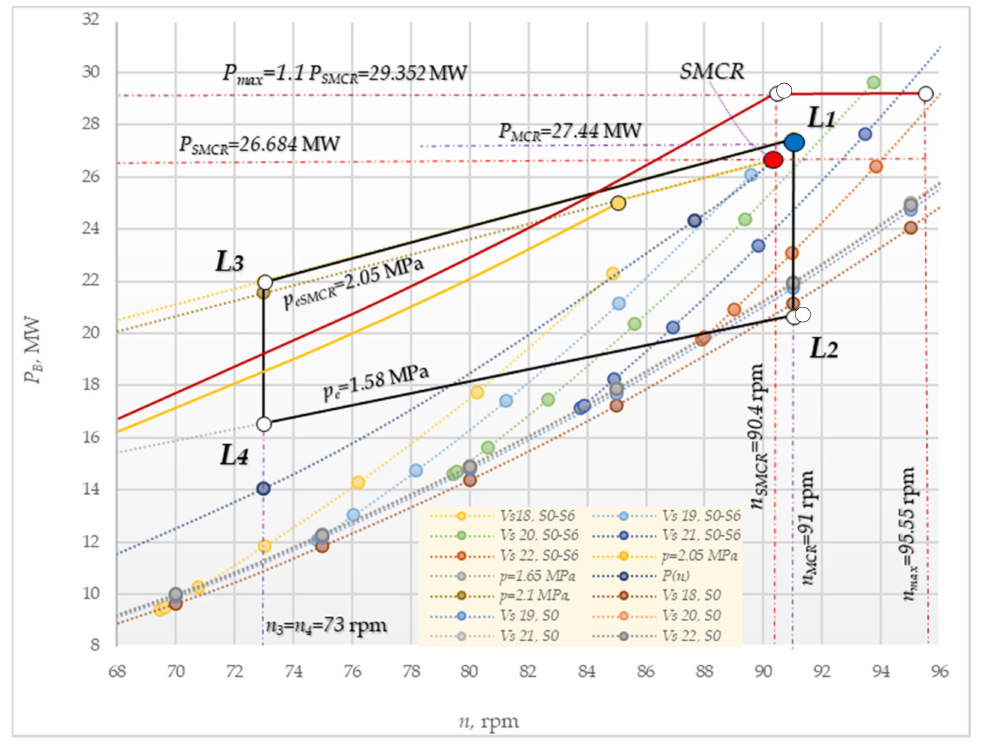
Figure 10. Engine layout diagram and propulsion balancing break power for various SI S and V S .